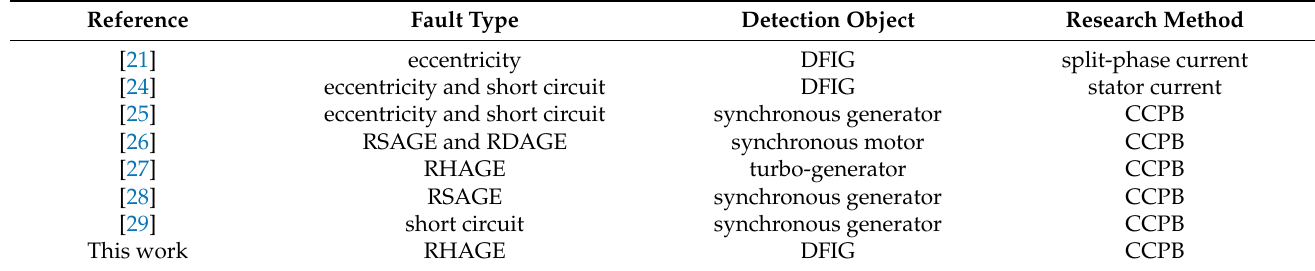
Table 1. Overview of previous work in the